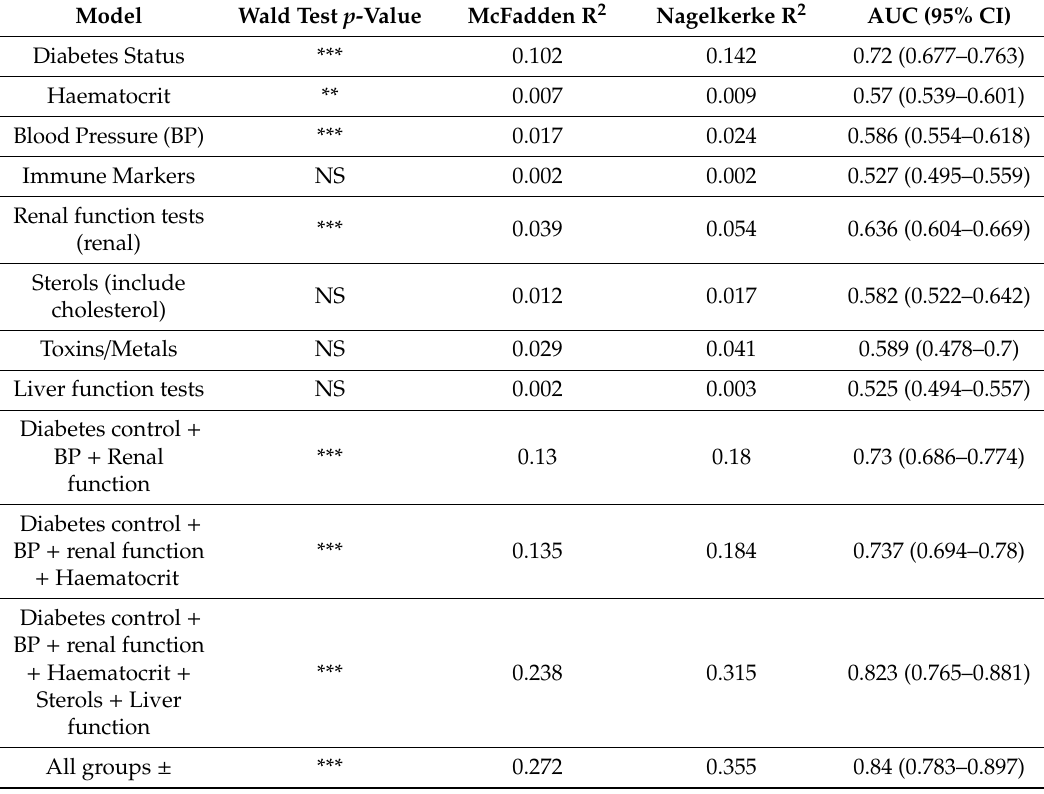
Table 5. Final clinical risk